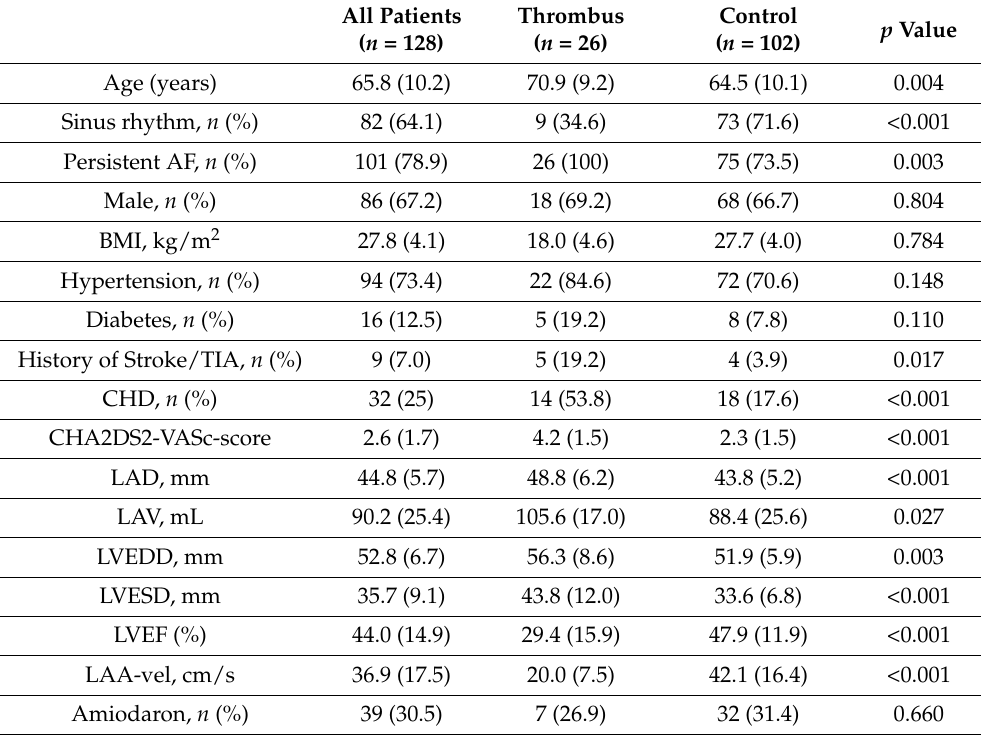
Table 1. Baseline characteristics in each